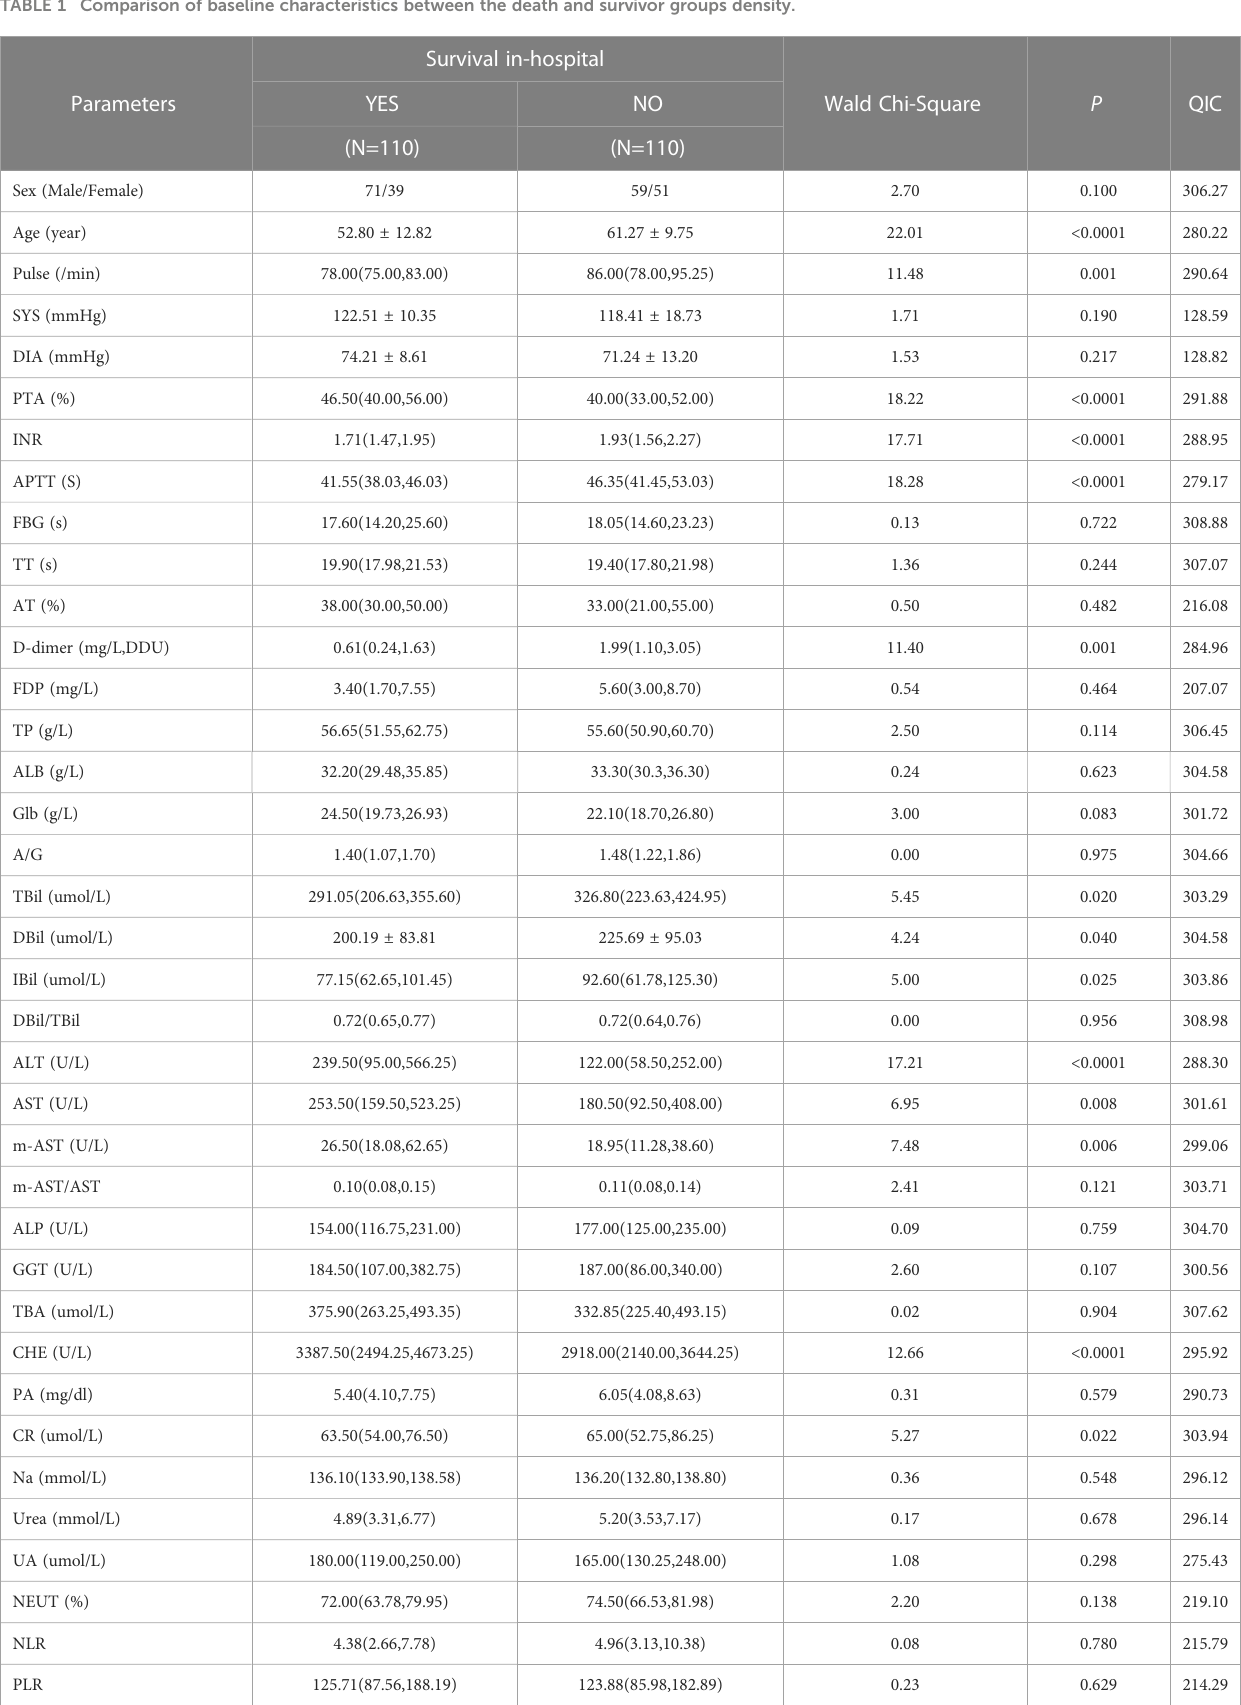
TABLE 1 Comparison of baseline characteristics between the death and survivor groups